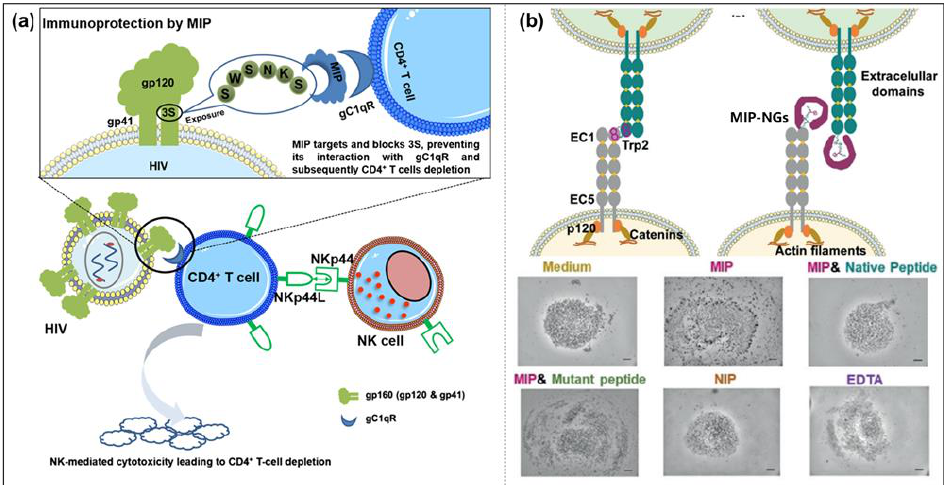
Figure 13. Mechanism of the action of MIP targeting and blocking 3S ( a ); MIP-NPs targeting an N-terminal epitope of cadherin, block Trp2 and abrogate adhesion between opposite cells, and cell aggregation of HaCaT cells when incubated with medium, MIP-NPs, MIP-NPs in the presence of the native peptide or the mutant peptide 2, NIP-NPs, and EDTA ( b ). Reprinted with permission from Ref. [159,160]. Copyright 2019, ACS; 2019, Wiley.